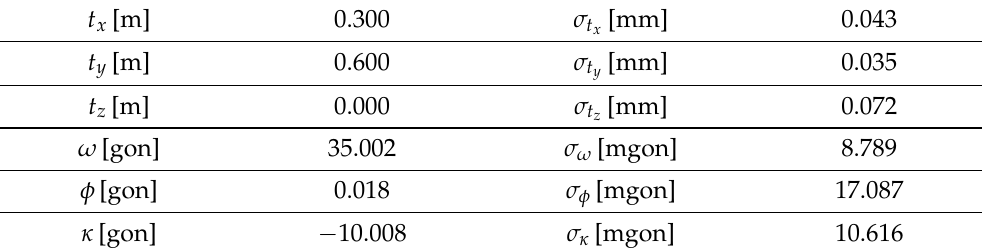
Table A3. Results of the estimated rigid body movement after having extended S CS (data set V20, a = 1, n CS , val = 11, n CS , ex = 20) [30].